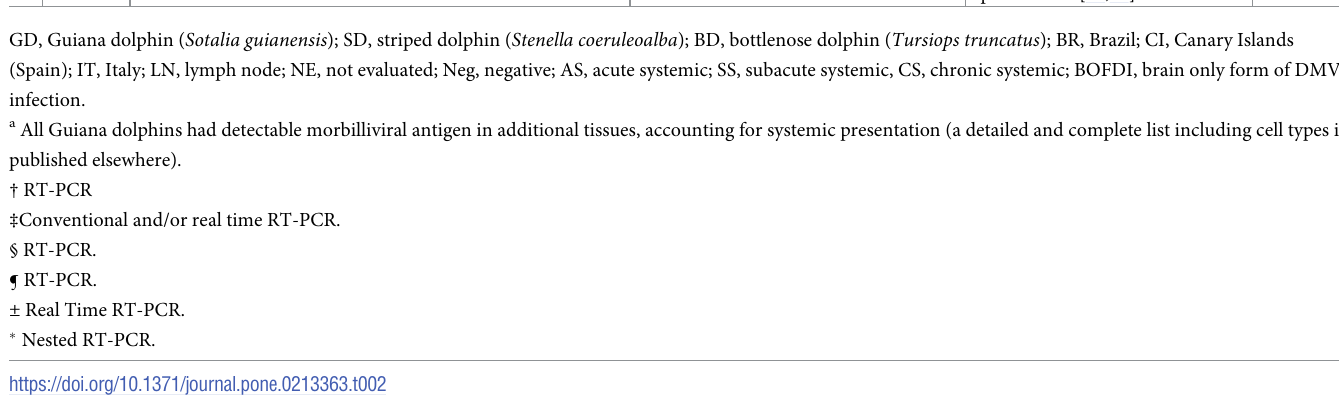
GD, Guiana dolphin ( Sotalia guianensis ); SD, striped dolphin ( Stenella coeruleoalba ); BD, bottlenose dolphin ( Tursiops truncatus ); BR, Brazil; CI, Canary Islands (Spain); IT, Italy; LN, lymph node; NE, not evaluated; Neg, negative; AS, acute systemic; SS, subacute systemic, CS, chronic systemic; BOFDI, brain only form of DMV infection. a All Guiana dolphins had detectable morbilliviral antigen in additional tissues, accounting for systemic presentation (a detailed and complete list including cell types is published